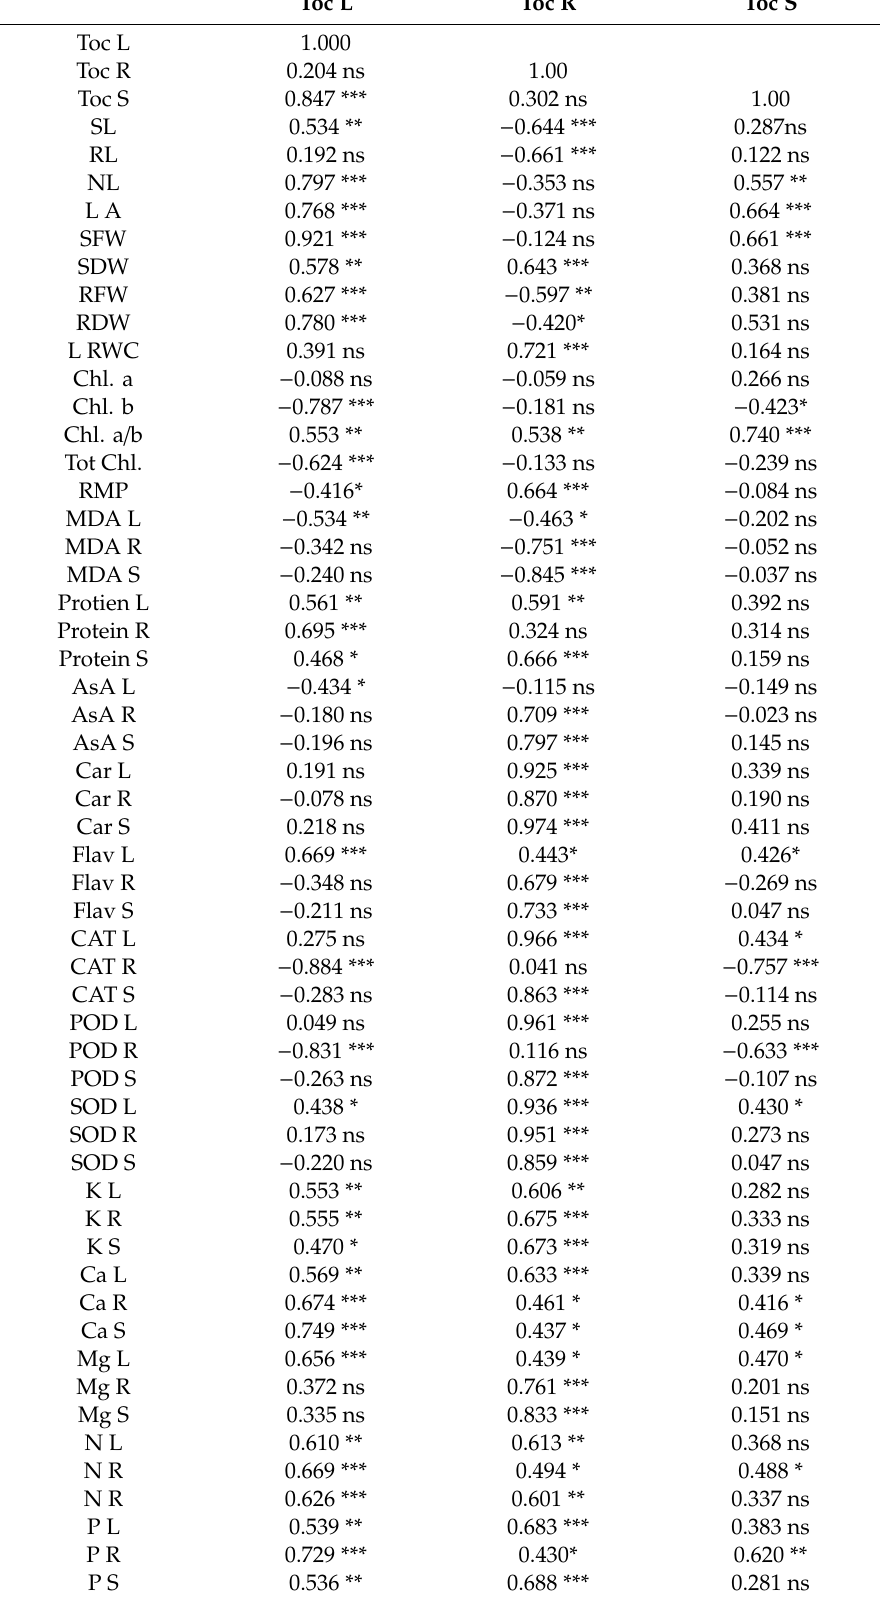
Table 6. Spearman correlation coe ffi cient values ( r 2 ) of Toc levels in di ff erent plant parts of maize with growth, biochemical attributes, and nutrient